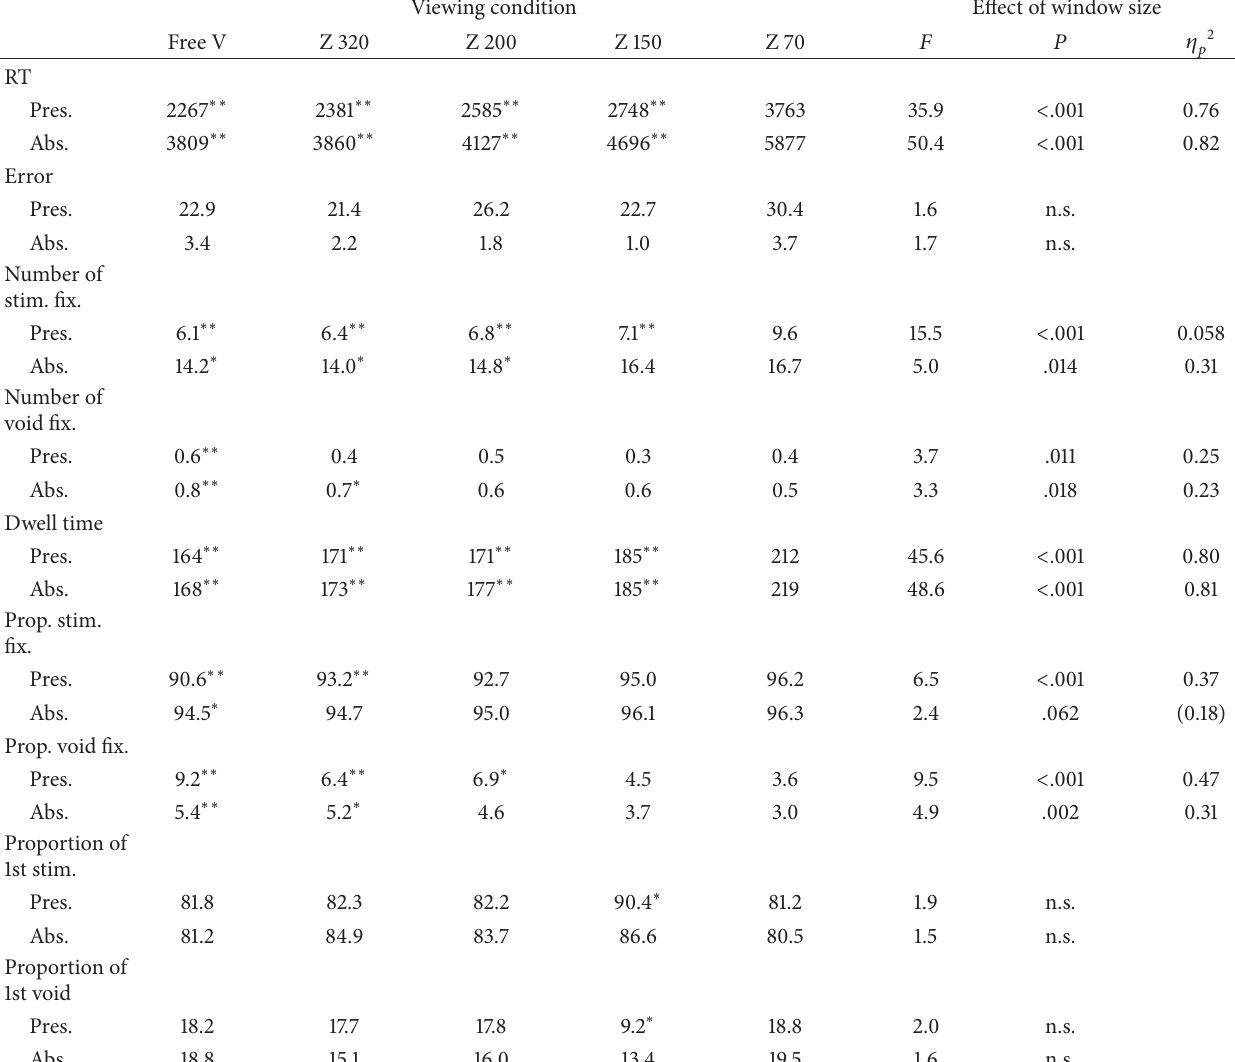
Table 2: Experiment 2: effect of window size on eye movement parameters. Viewing